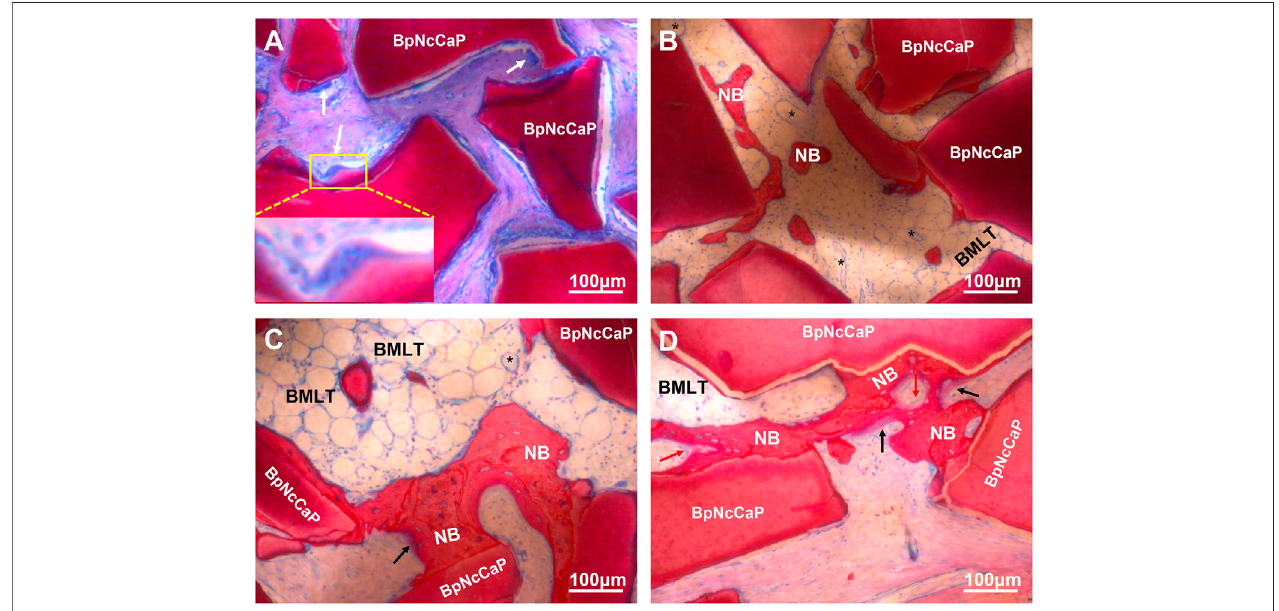
FIGURE 9 | Light micrographs in high magni fi cation of BpNcCaP (A) and BpNcCaP+50 μ g BMP-2 (B – D) 5 weeks after subcutaneous implantation in rats. NB: New bone;Blackasterisk: Bloodvessels;Blackarrow: Unmineralized boneareas;Whitearrow: Foreign bodygiant cells(FBGCs); Redarrow: Osteoblasts; BMLT: Bone marrow-like